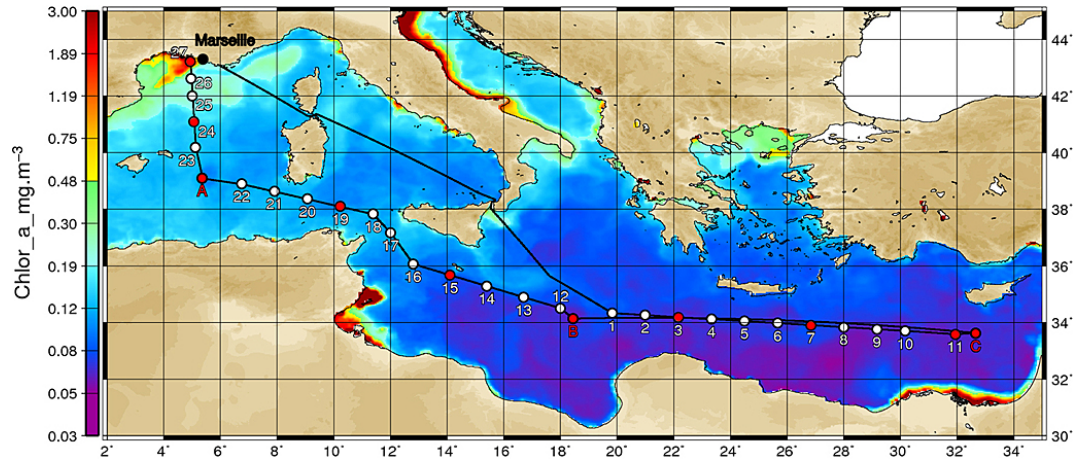
Fig. 1. Map of the BOUM cruise superimposed on a SeaWiFS ocean color composite indicating values of total chl- a . Location of stations analyzed in the present study is indicated by red dots. The track of the cruise is indicated, with all sampled stations.